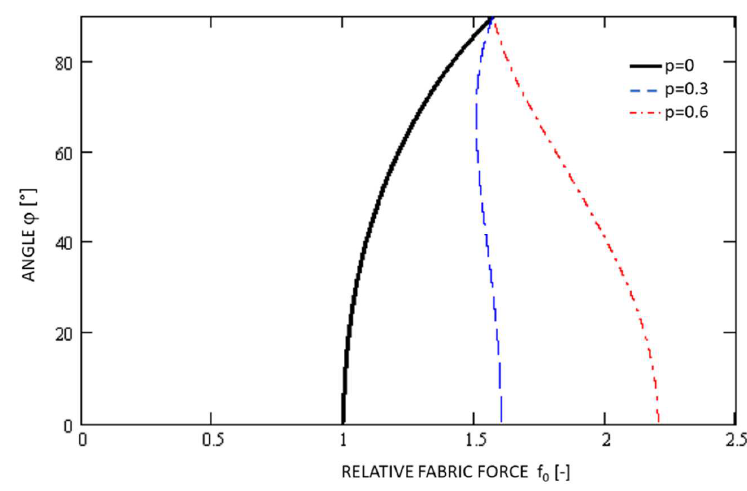
Figure 9. The plot of the functions φ = ( f 0 , p ).